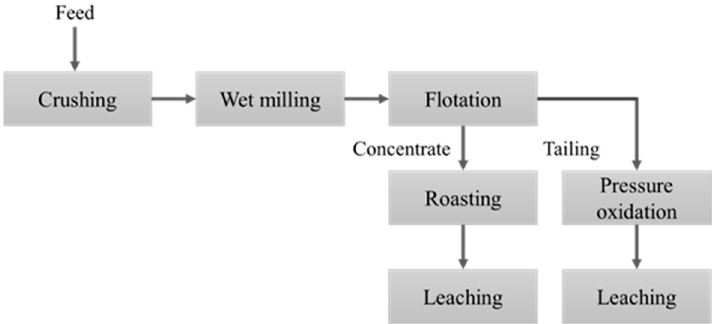
Figure 1. The proposed process for the treatment of refractory gold ore. As a first step in identifying the optimal conditions for C-matter flotation from Goldstrike ore, the effect of methyl isobutyl carbonyl (MIBC) as a frother was investigated, with a focus on bubble and foam/froth formation. In flotation, it is well known that the frother reduces the bubble size by preventing bubble coalescence [7,8]; therefore, bubble size decreases with increasing frother concentration until it reaches a minimum. The frother concentration after which bubble size remains constant is known as the critical coalescence concentration (CCC) [7,8]. The CCC is a function of the frother type; MIBC is reported to have a CCC between 9 and 12 ppm [7,9–11]. As the MIBC concentration increases, the Sauter mean diameter of bubble (D 32 ) decreases from 2.0–4.0 mm at 0 ppm to around 1.0 mm at the CCC, depending on test conditions [7,9,10,12]. With an increase in MIBC concentration from CCC to 15–100 ppm, the D 32 shows a minor change of ~0.3 mm.